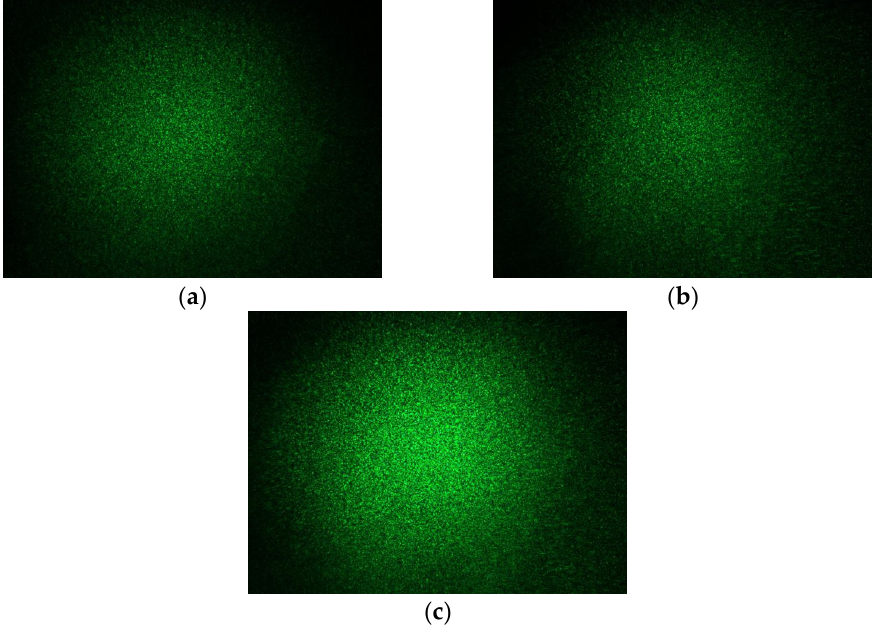
Figure 7. The images captured by CCD. ( a , b ) are the independent imaging of the measured object and the reference object, respectively; ( c ) is one of the speckle interferograms formed by ( a , b ). Then, we measure the vibrations with the same vibration frequency (10 Hz selected in the article) and different amplitudes, as shown in Figure 9. For the same reason mentioned above, we choose the light intensity curves of 800 frames in 2